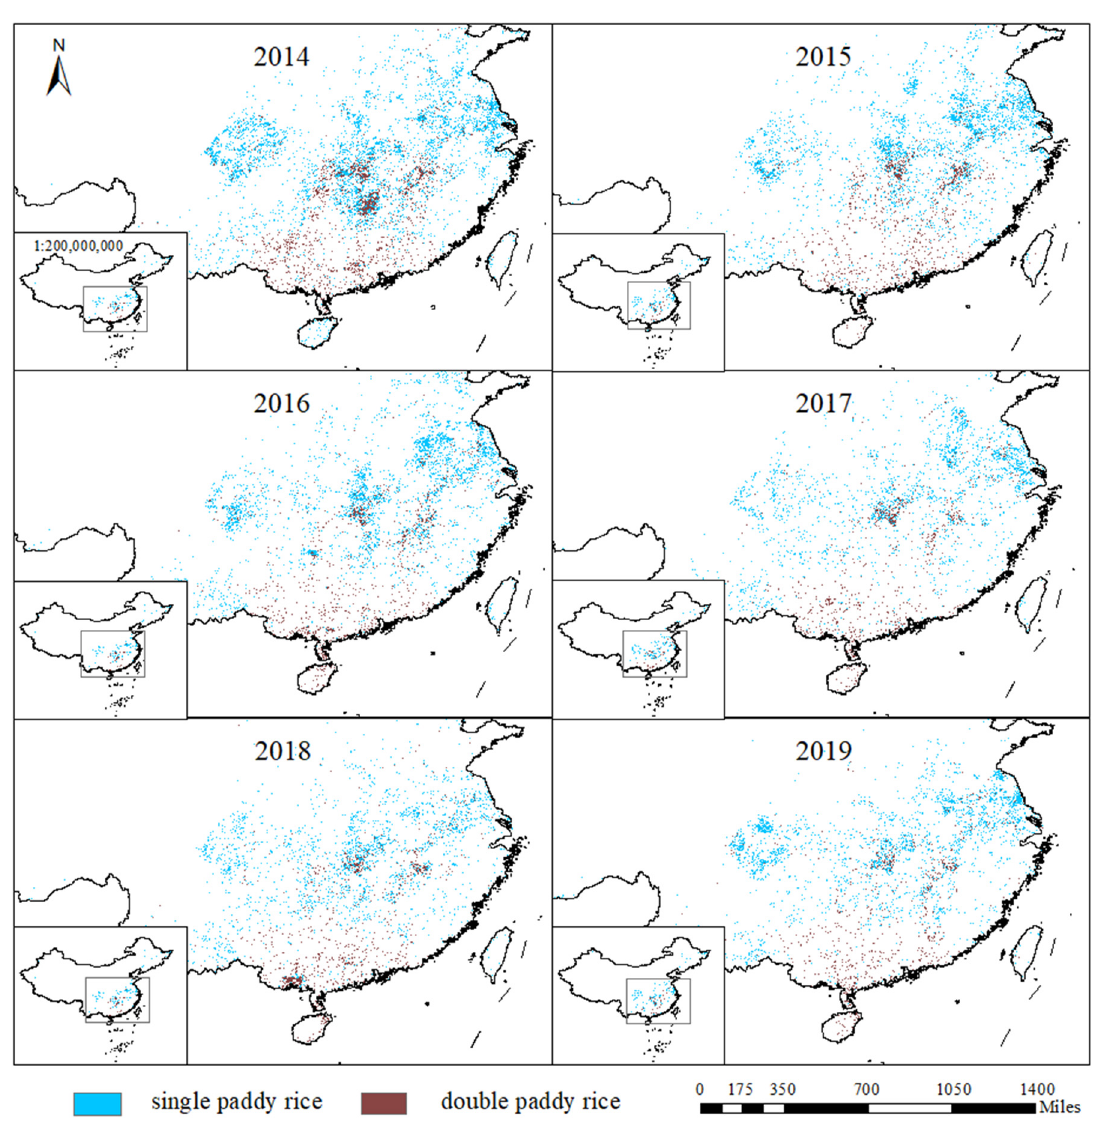
Figure 5. Paddy rice maps derived from Landsat images with the effective flood signal-base phenology (EFSP) method in China (excluding the Nansha Islands) from 2014 to 2019.